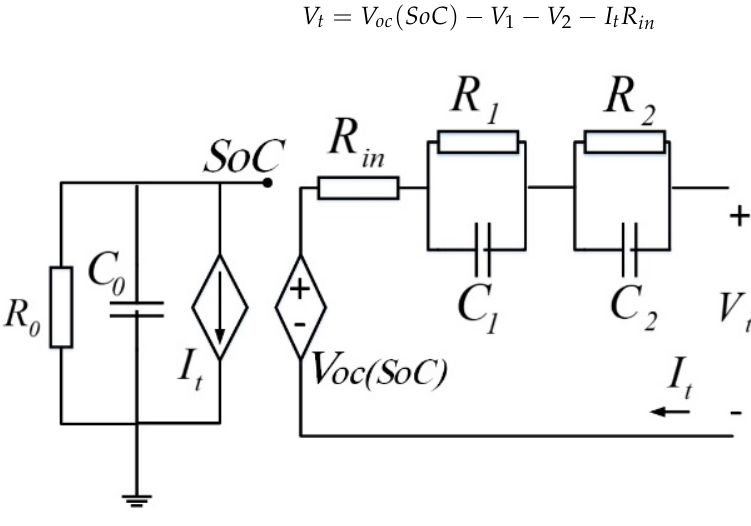
Figure 2. The battery model.